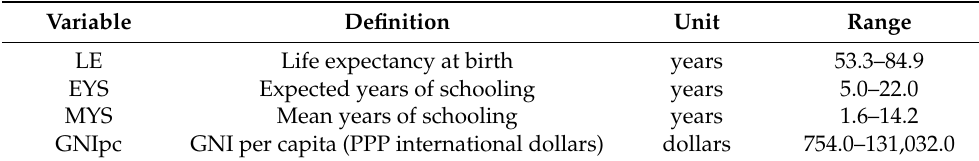
Table 1. Variables used to compute the HDI